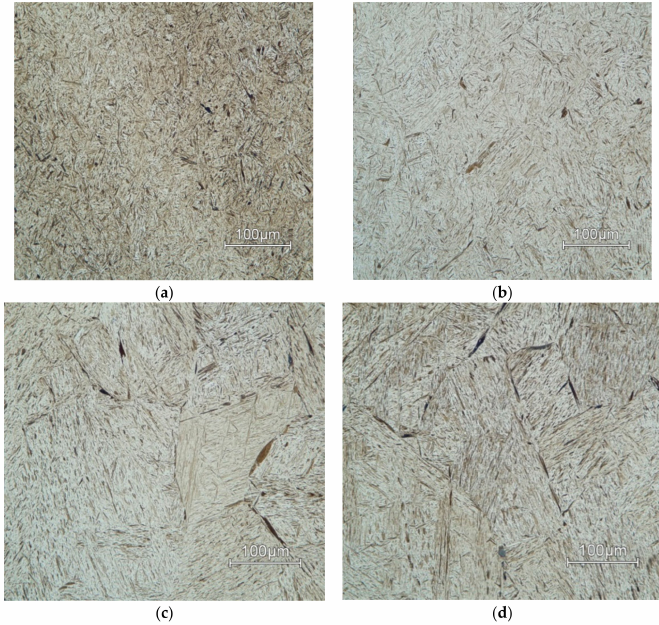
Figure 15. Microstructure of samples deformed at strain rate ϕ ’ = 10 s − 1 at temperature: ( a ) T = 900 ◦ C; ( b ) T = 1000 ◦ C; ( c ) T = 1100 ◦ C; ( d ) T = 1200 ◦ C.